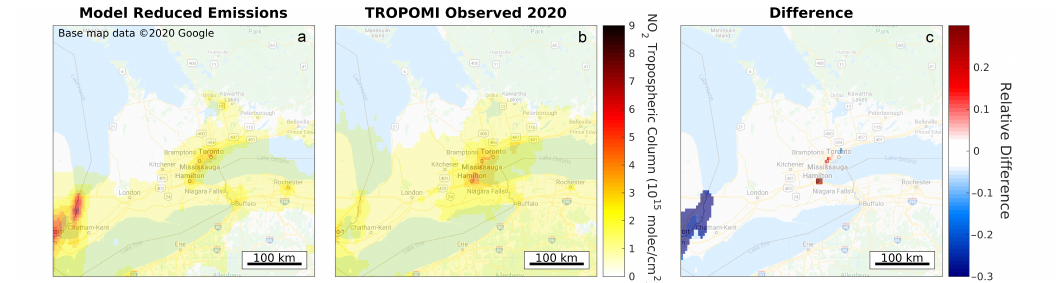
Figure 3. Model NO 2 VCDs from the reduced emissions scenario ( a ) and observed TROPOMI NO 2 VCDs ( b ) over southern Ontario averaged over the period 1 April – 8 May 2020. The relative differences ((observations-model)/model) are shown in panel ( c ) for areas that exceed 3 × 10 15 molec/cm 2 . Note that emissions have only been reduced in Canada; thus, large differences can be seen for the US cities near the border, especially